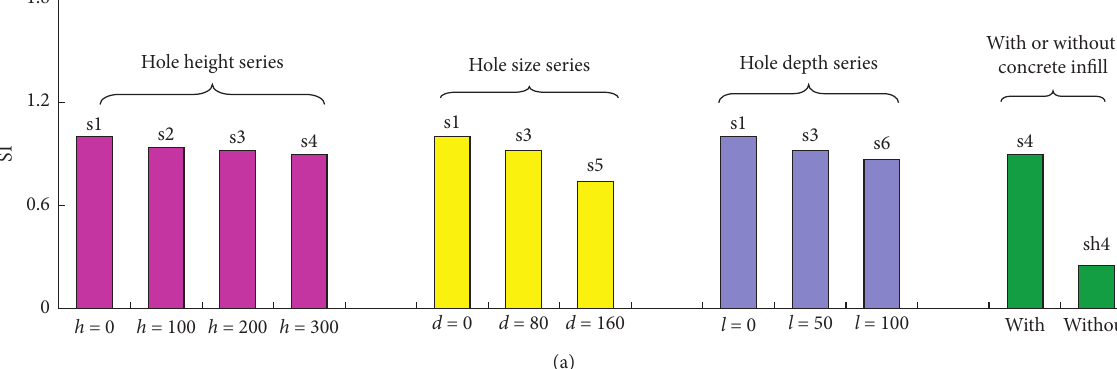
With or without concrete